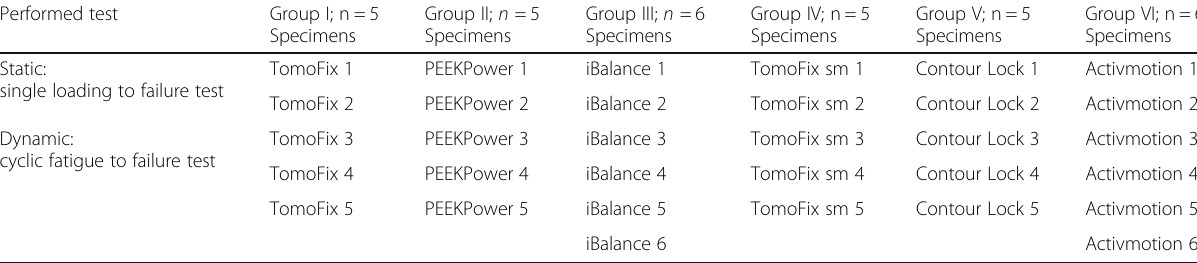
Table 2 Specimen grouping and assignment, depending on used implants and the performed test Performed